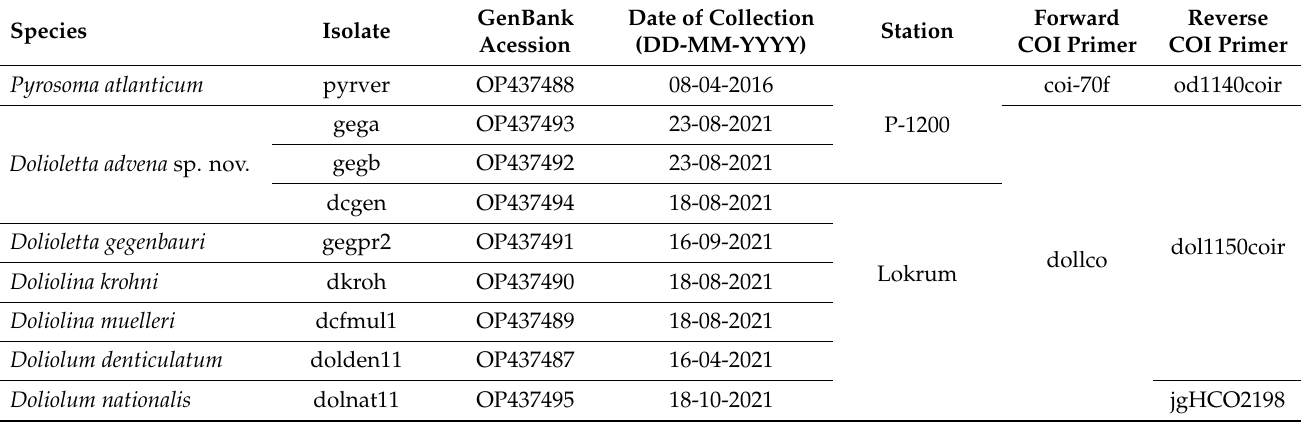
Figure 1. Position of stations Lokrum (42°37 ′ 21 ″ N, 18°06 ′ 05 ″ E) and P-1200 (42°13 ′ 01 ″ N, 17°42 ′ 50 ″ E) in the South Adriatic. Table 1. List of sequenced pyrosomatid and doliolid species, GenBank accession numbers of their respective COI sequences, date of collection of animals, stations at which they were collected and primers used for COI